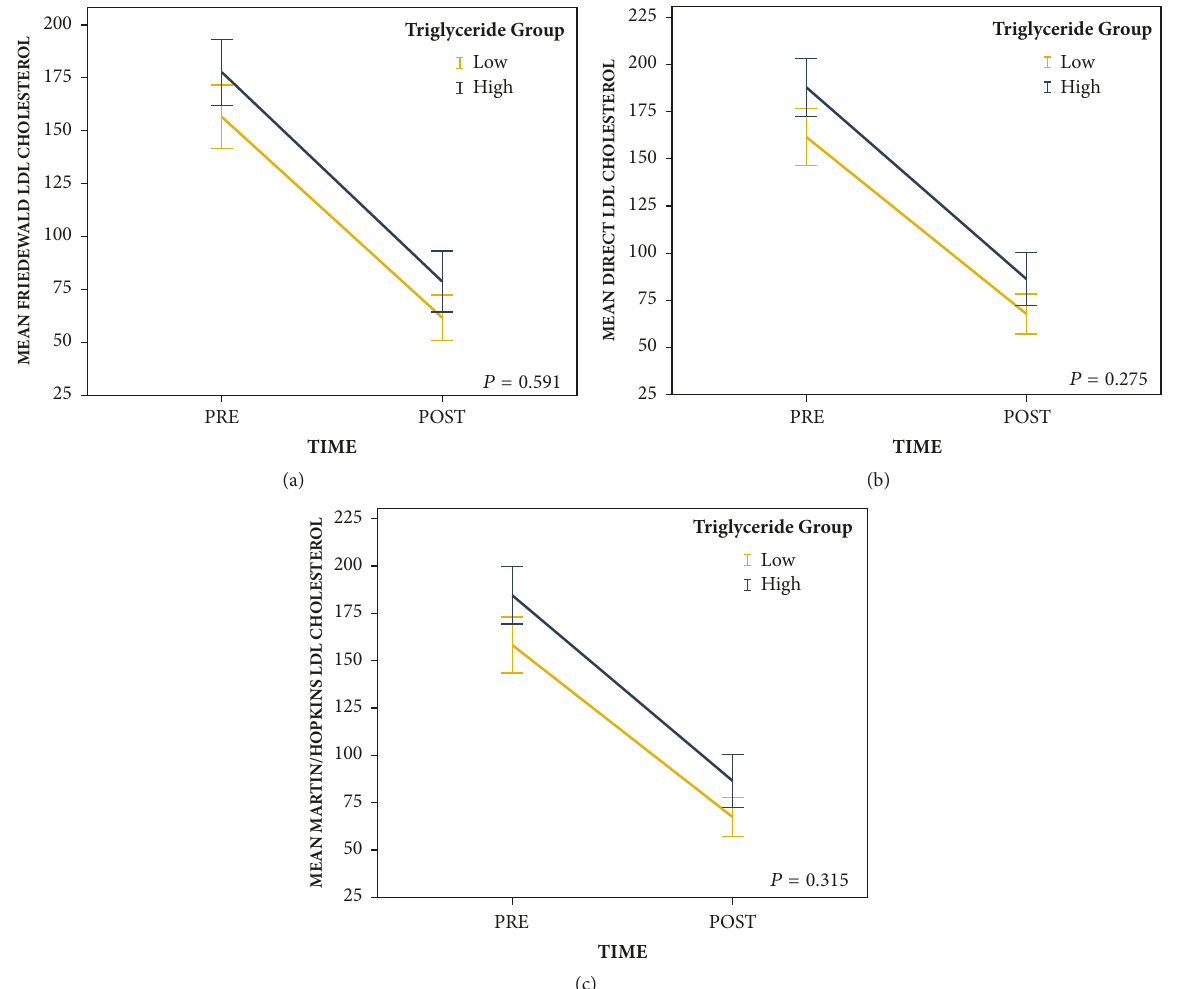
Figure 2: Change in LDL cholesterol levels from pretreatment to posttreatment by pretreatment triglyceride groups (error bars: 95% CI).